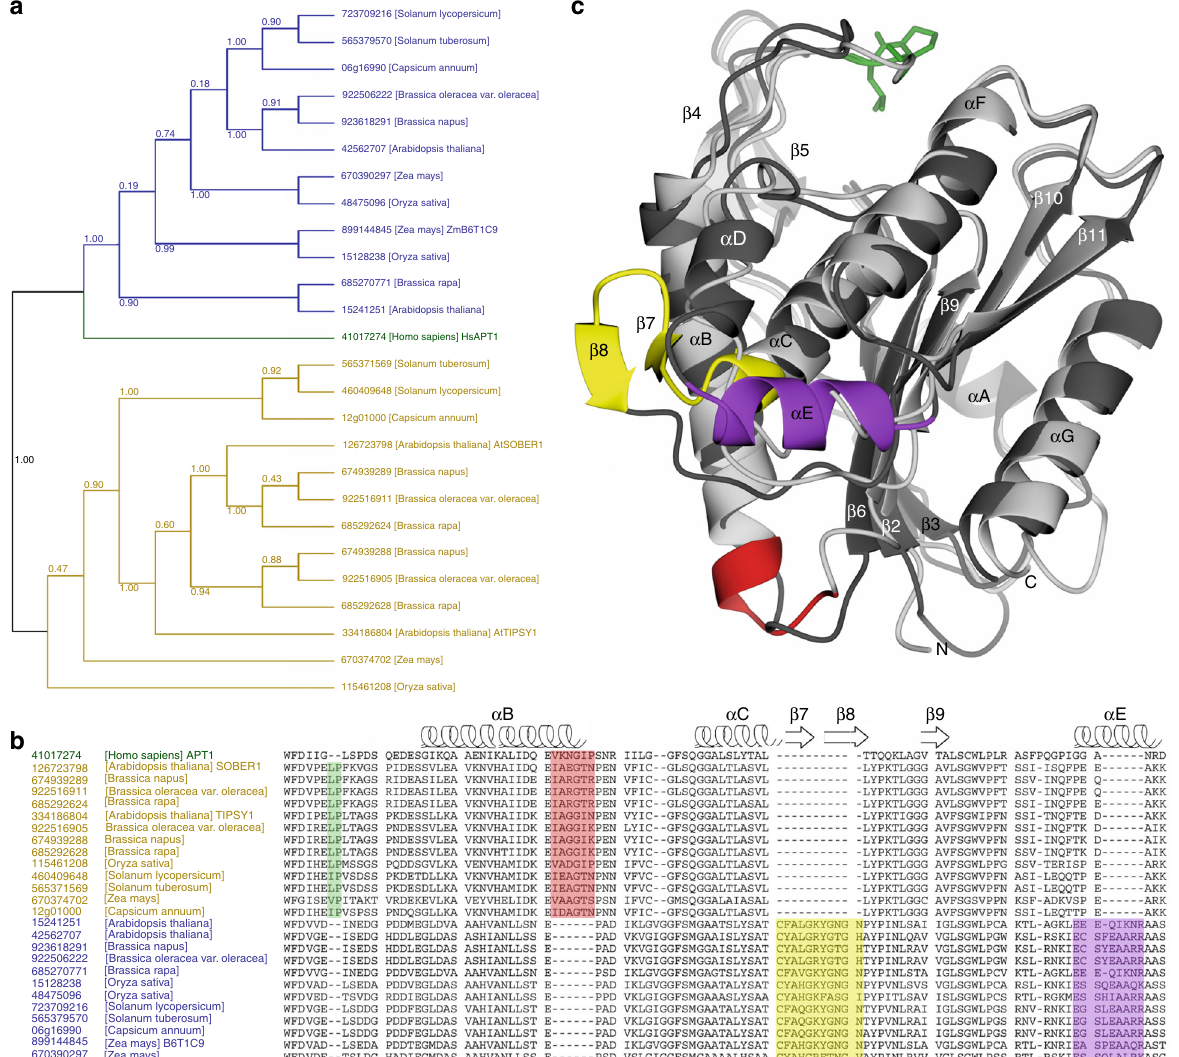
Fig. 1 Phylogenetic and structural analysis of plant hydrolases reveals two major protein clades. a Phylogenetic tree of related plant hydrolases. b Multiple sequence alignment highlighting conserved sequence blocks within the clades. c Superimposition of AtSOBER1 (gray) and ZmB6T1C9 (black) showing the structural elements encoded by those blocks in the same